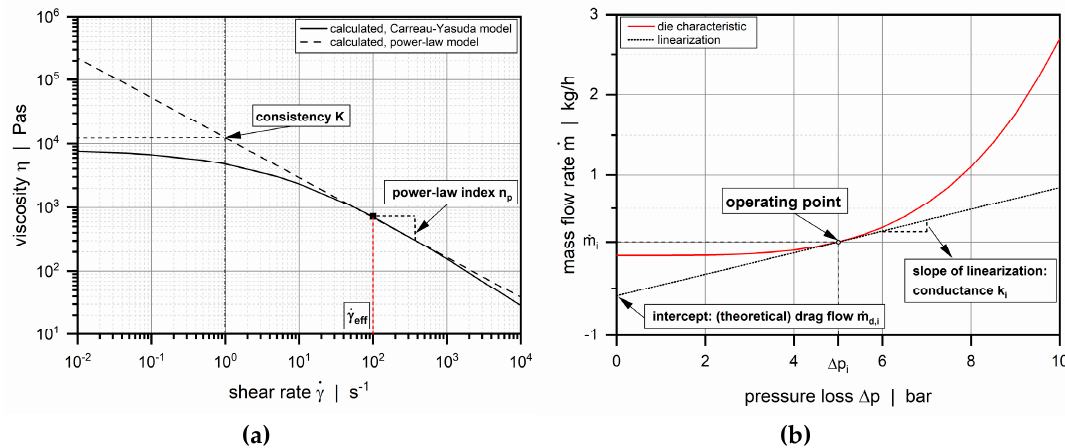
Figure 12. Conversion of Carreau–Yasuda parameters into power law parameters ( a ) and linearization to the die characteristic curve at operating point ( ∆ p i | ˙m i ) ( b ).